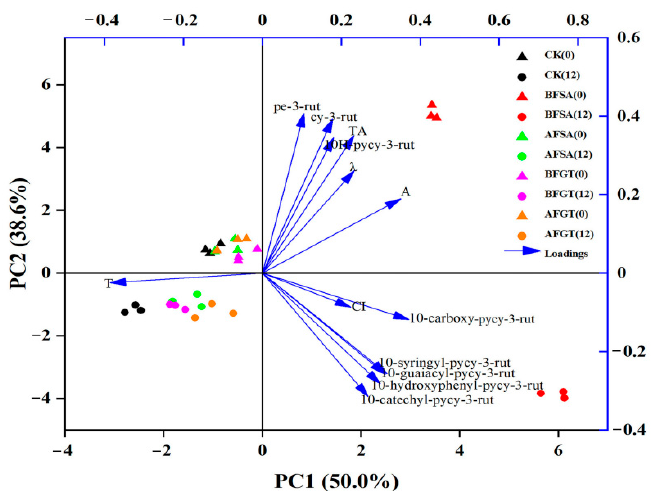
Figure 8. Principal component analysis for cherry wine during aging (0: aging for 0 months; 12: aging for 12 months; arrow: the principal component load; λ : wavelength at maximum absorbance of cherry wine; A: maximum absorbance of cherry wine; CI: color intensity; H: hue; TAs: total monomeric anthocyanins; py: pyrano; cy: cyanidin; pe: peonidin; rut: 3- O -rutinoside).